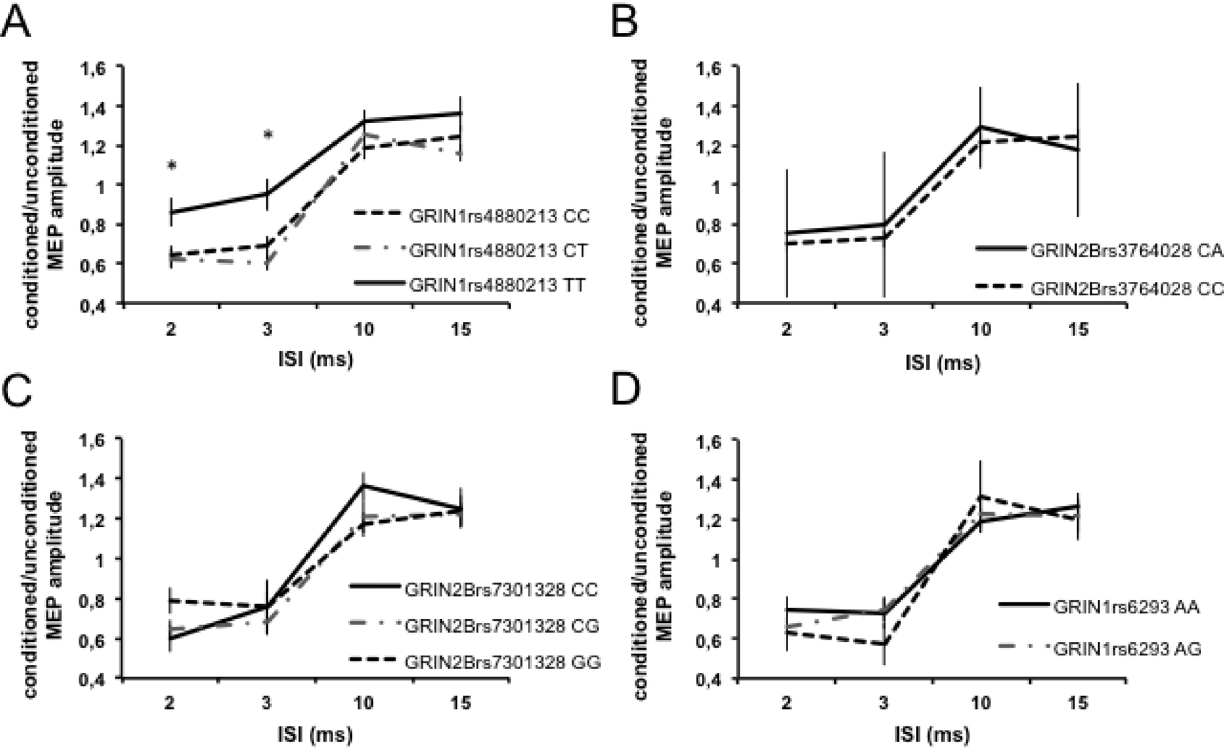
Figure 1. Effect of SNPs in the GRIN1 and GRIN2B genes on cortical excitability in MS. Role of A) GRIN1 rs4880213 polymorphism in the regulation of cortical excitability. In subjects carrying the ‘TT’ genotype, SICI was significantly lower than in the other subjects at 2 and 3 ms interstimulus intervals (ISI). No significant effect of B) GRIN2B rs1805247, C) GRIN2B rs7301328 and D) GRIN1rs6293 SNPs was found on SICI/ICF. In the four panels, the x-axis indicates the ISI in ms, the y-axis shows the MEP size elicited by paired-pulse stimulation. * means p , 0.05.